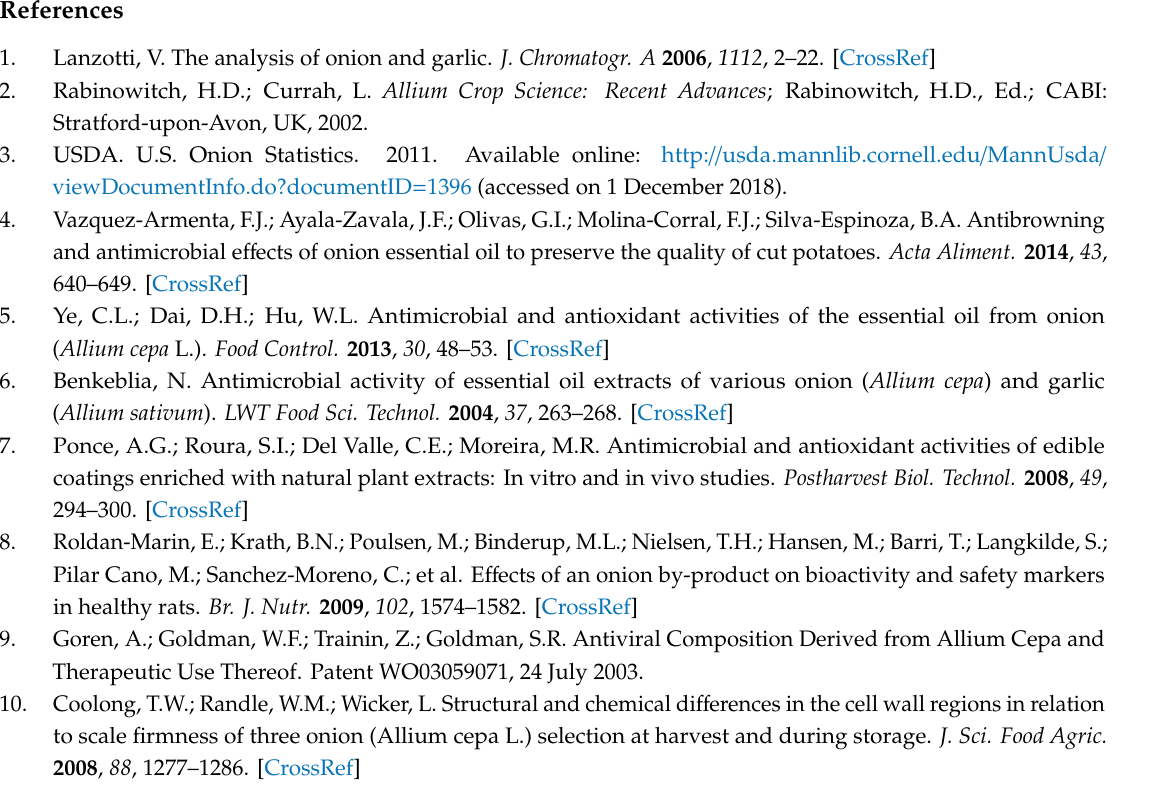
Supplementary Materials: The following are available online, file S1: Brief description of preliminary trials aimed at optimizing sample amount, and exposure time and